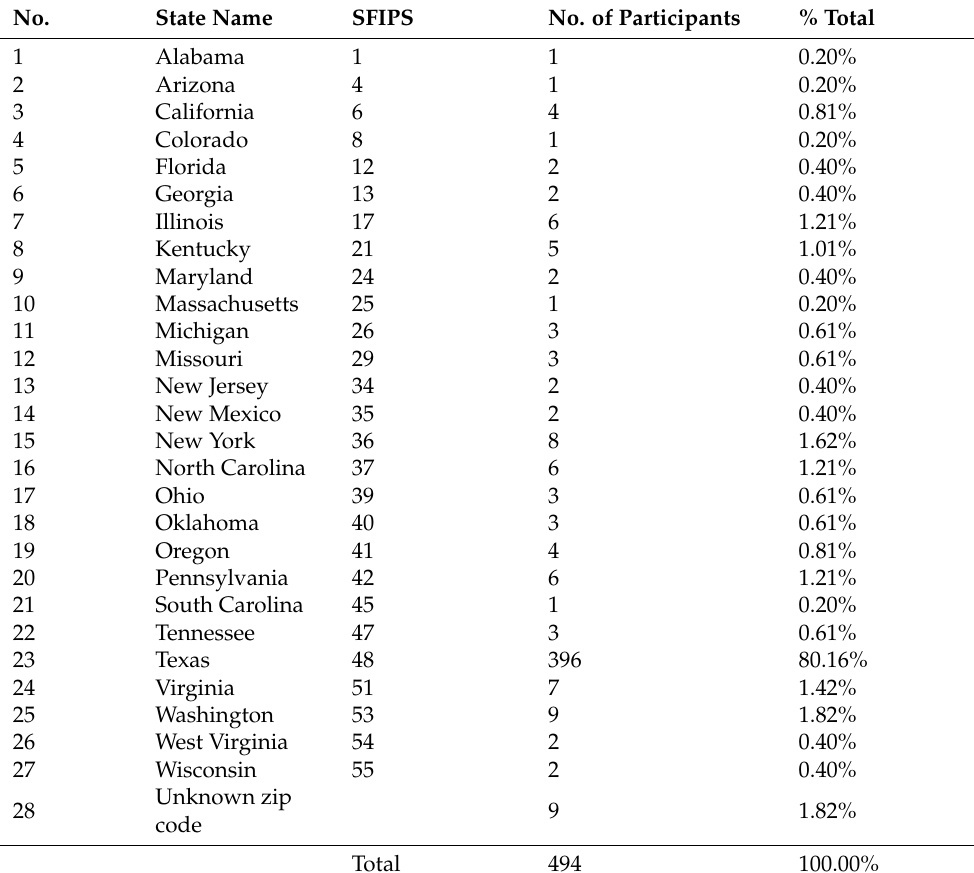
Table A1. Geographical distribution of survey